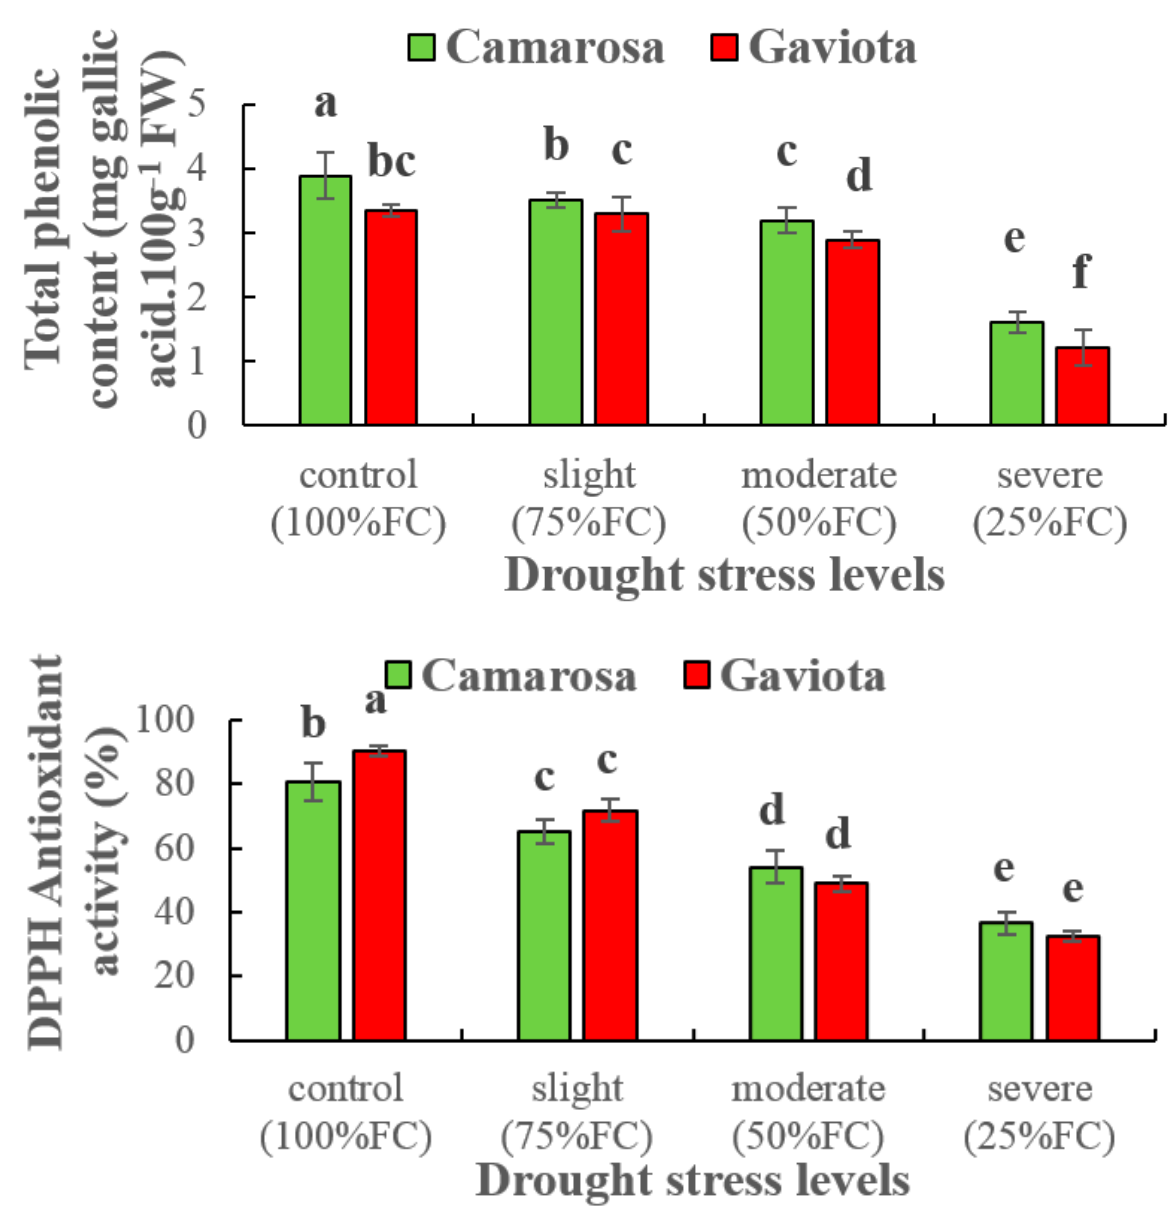
Figure 1. Effects of different drought stress levels on total phenolic content ( a ) and DPPH antioxidant activity ( b ) of two strawberry cultivars (Camarosa and Gaviota). Values are means ± SE (n = 3). Values with different letters are significantly different at p < 0.05 according to Duncan’s multiple range